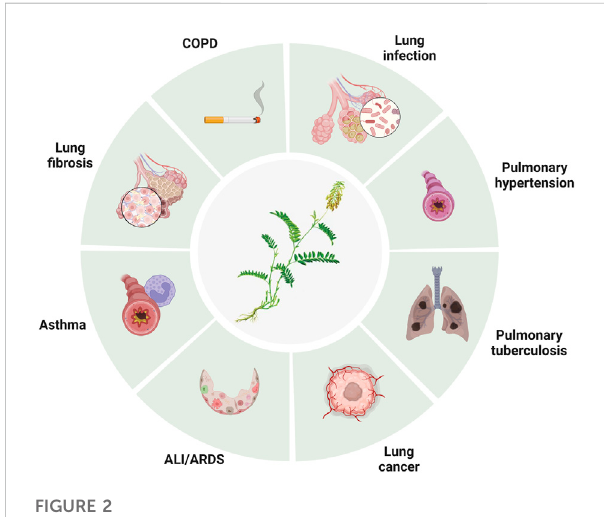
FIGURE 2 The applications of baicalin in lung